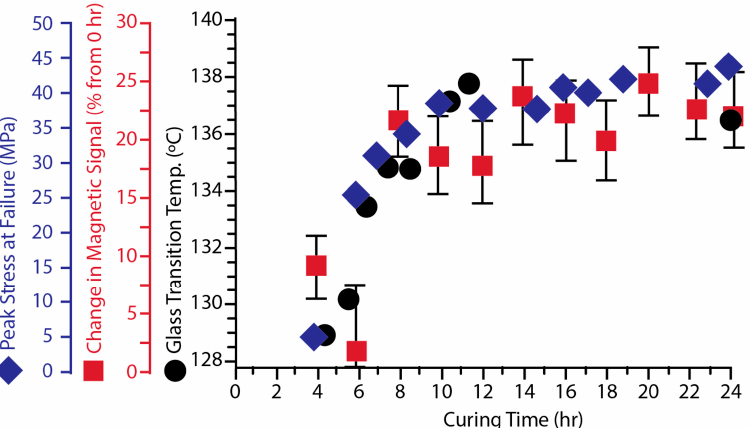
Figure 5. Undoped adhesive peak stress (blue), change in the magnetic signal (red), and glass transition temperature (black) with respect to adhesive curing time.